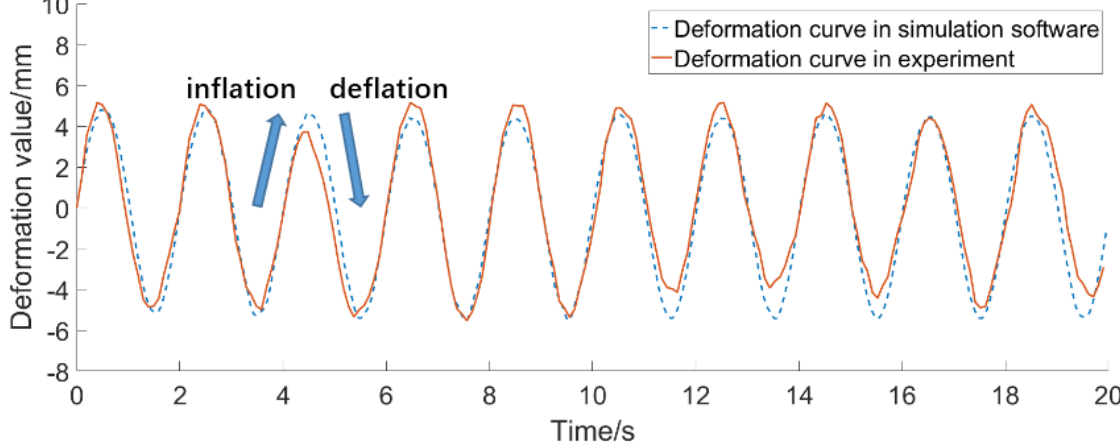
Figure 7. Comparison between simulation and experiment deformation curves of the single soft